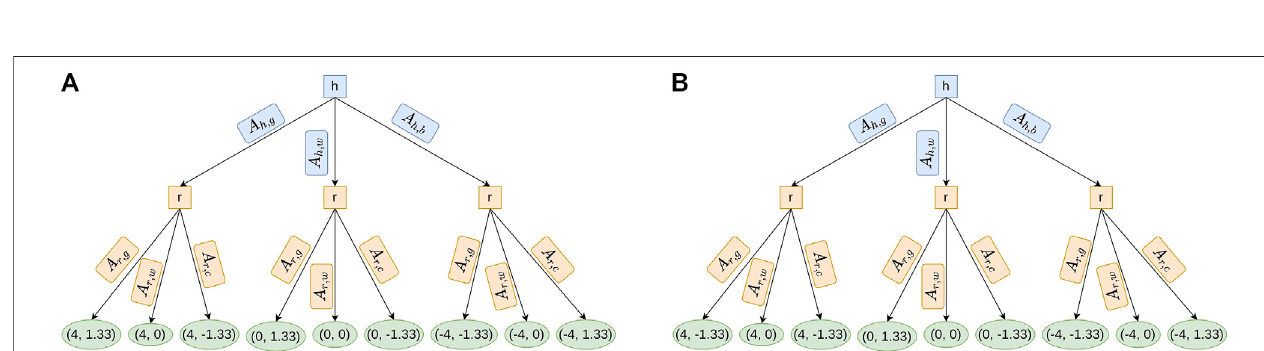
FIGURE4| Tree representation ofthetask based on theutility function in C 1 and C 2 . Noticethat thedifference between both fi gures istheutilityvalue oftheaction A r , g ,oftherobot(1.33and − 1.33).Itisbecause C 1 (onthecontraryof C 2 )doesnotminimizethetime,sotherobotcontinuestomakeanactioneveniftherobotisslower thanthewell-performinghuman. (A) Thistreeisobtainedbysimulating aniteration ofthetaskwithoutoptimization( C 1 ).Theutilities( fi rstforhumanagent andsecondfor (cid:2) 20 s , t (cid:2) 60 s and t (cid:2) 80s. (B) Thistreeisobtainedbysimulatinganiterationofthetaskoptimizedbythetimemetric robotingreenellipses)arecalculatedfor t A A r h (cid:2) 20 s , t (cid:2) 60 s and t (cid:2) 80 s. ( C 2 ). The utilities ( fi rst for human agent and second for robot in green ellipses) are calculated for t A A r h